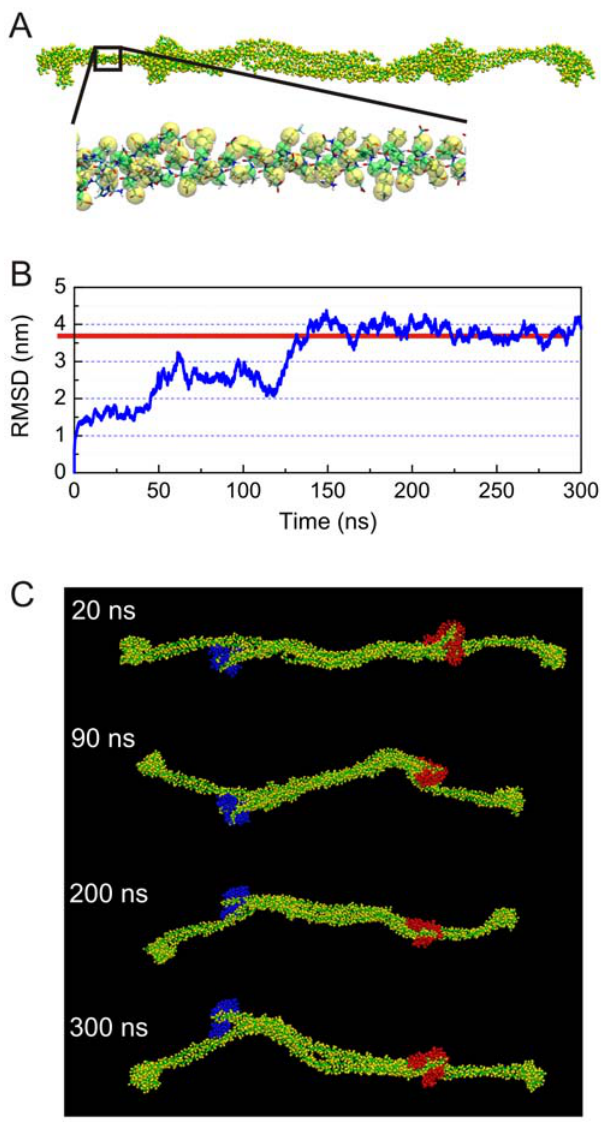
Figure 11. Coarse-grained representation of the vimentin tetramer (in explicit water) and structural stability of the vimentin tetramer structure at time-scales of hundreds of nanoseconds. By replacing the full atomistic representation with a bead model (where several beads reflect one amino acid), much longer time-scales can be reached. Panel A shows the coarse-grained representation of the vimentin tetramer (water molecules not shown for clarity). Panel B depicts the root mean square displacement function as a function of time, showing structural stability of the predicted structure. The root mean square displacement function provides a measure for how much a structure changes relative to the initial geometry. Panel C shows snapshots during the coarse-grained equilibration, indicating the head domains in a different color.